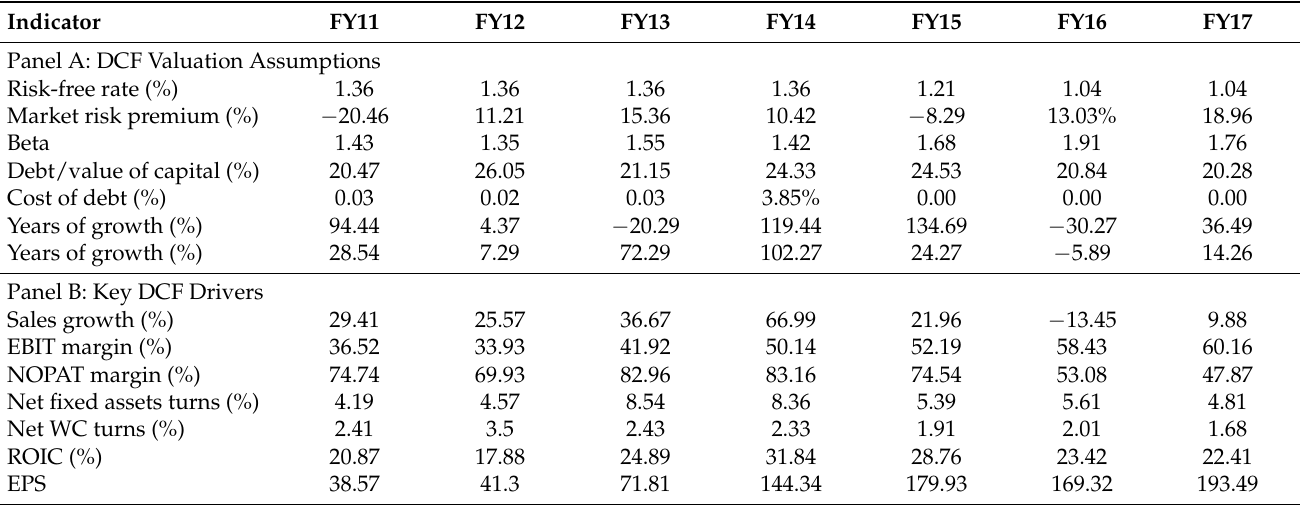
Table 5. DCF valuation.